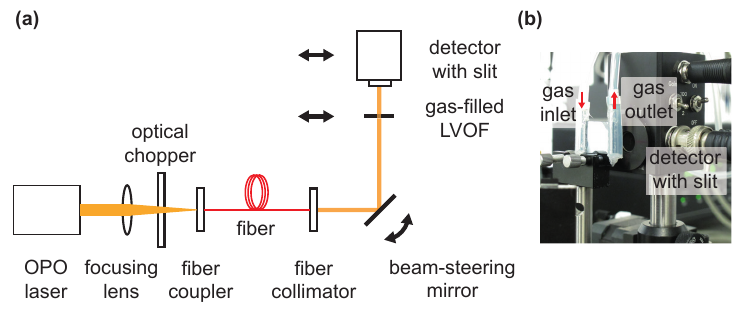
Figure 8. ( a ) schematic illustration of the optical characterization setup; ( b ) filter and detector shown in